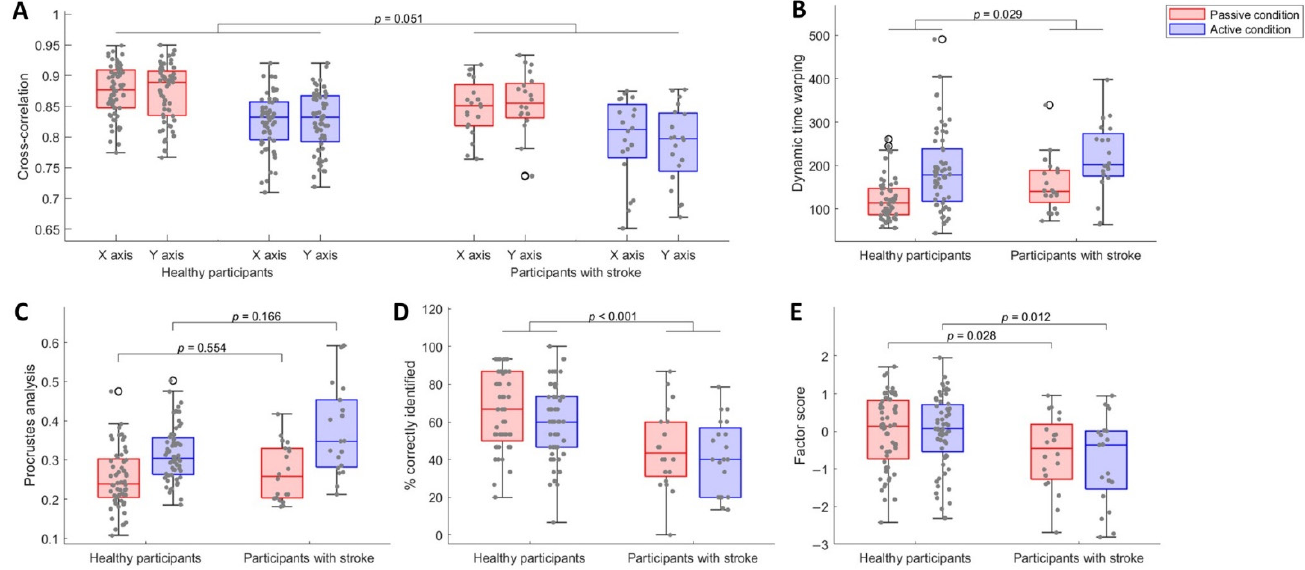
Figure 3. Results of the passive (in red) and active (in blue) sensory processing assessments. ( A ). Main effect for between-group analysis of three-way ANOVA for cross-correlation on X and Y axes. ( B ). Main effect for between-group analysis of two-way ANOVA for dynamic time warping. ( C ). Simple main effects for between-group analysis of two-way ANOVA for Procrustes analysis. ( D ). Main effect for between-group analysis of two-way ANOVA for the percentage of correctly identified shapes. ( E ). Between-group comparison of factor scores using independent t